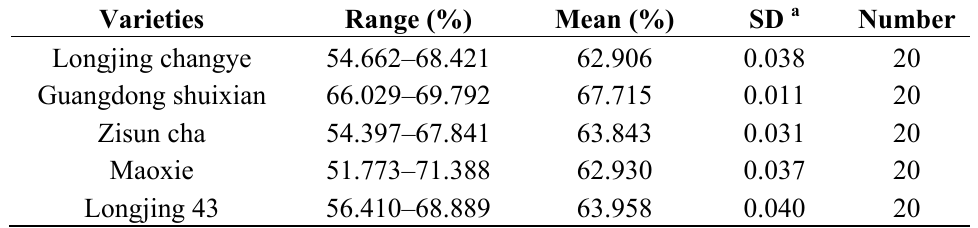
Table 2. Statistical information of moisture content (w.b., %) of samples in type I.